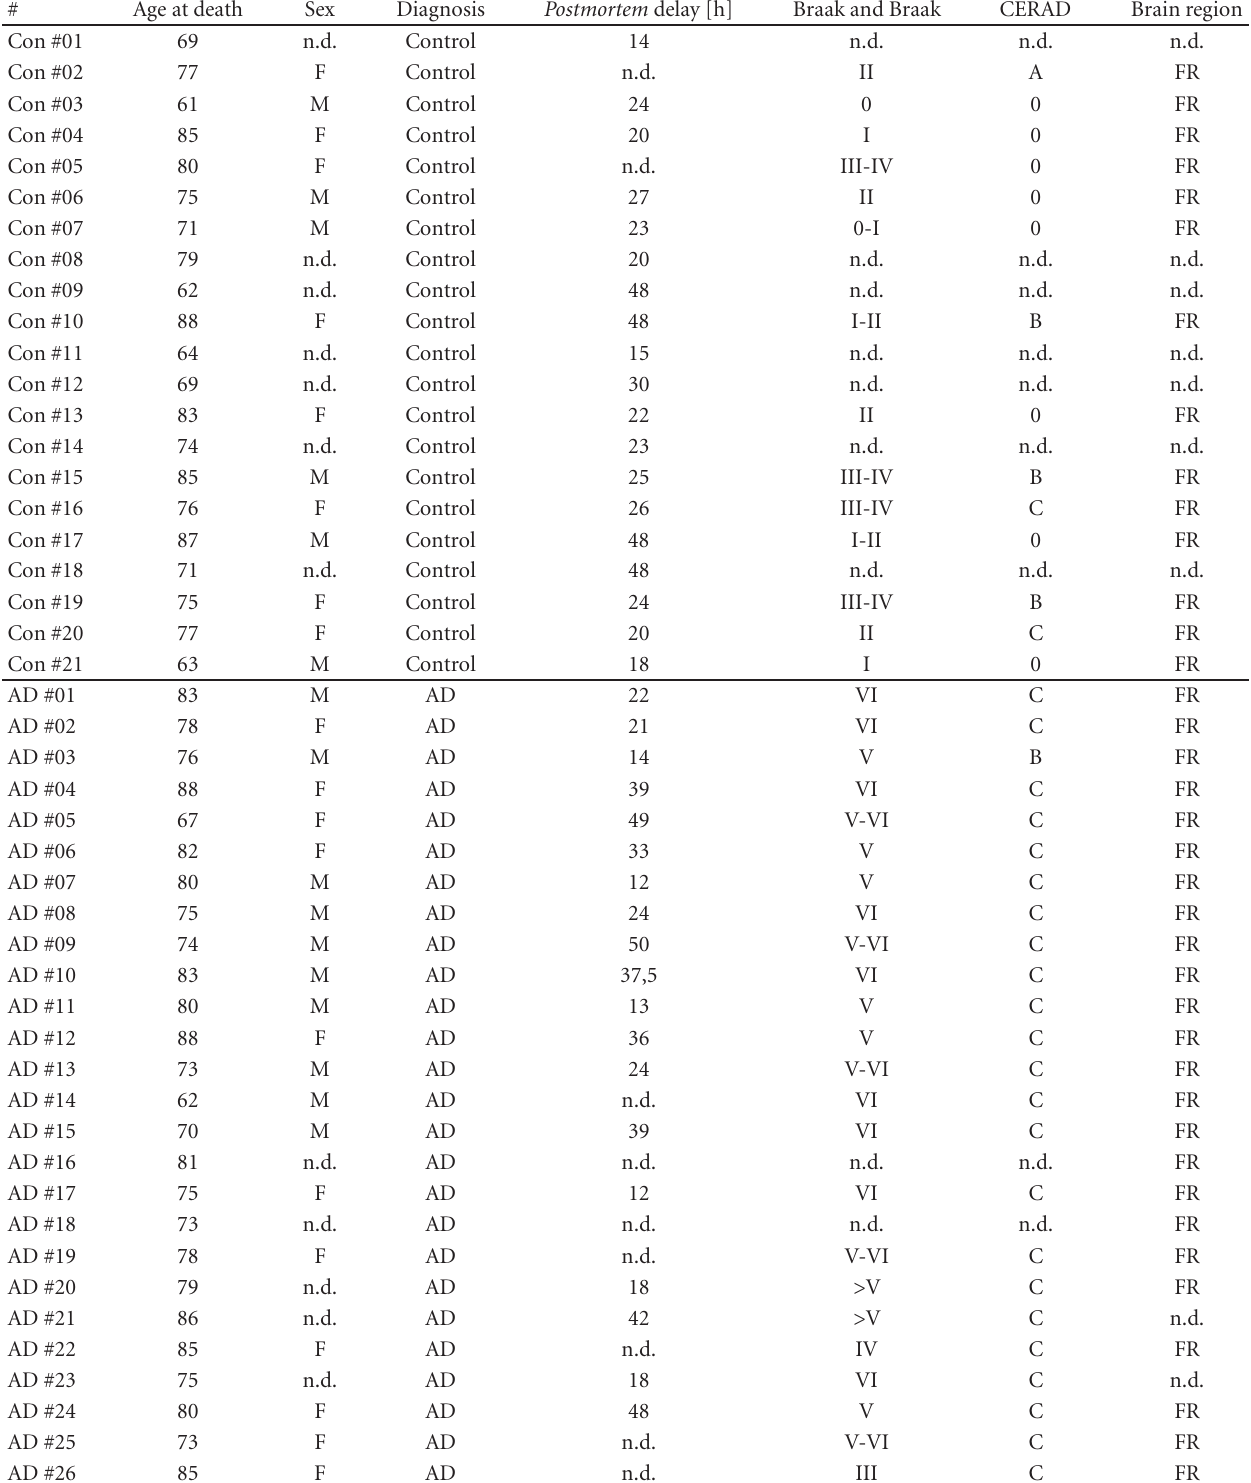
Table 1: List of all human brains ( n = 58) used for analysis. Human brain samples were kindly provided from BrainNet (Munich). In total, we used 58 human brain samples from 21 control and 37 AD patients. Brains were obtained from patients with an age at death between 61 and 88 years, and no significant di ff erences in age and gender were observed between control (mean 75 years) and AD patients (mean 78 years) group. Abbreviations used are AD = Alzheimer’s disease; F = female; M = male; CERAD = the consortium to establish a registry for AD, standardizing procedures for the evaluation and diagnosis if patients with AD. A, B, C, 0 as described in http://cerad.mc.duke.edu/; Braak and Braak = Braak and Braak stage of AD; H. Braak and E. Braak stages [36]; FR = frontal cortex; n.d. = not